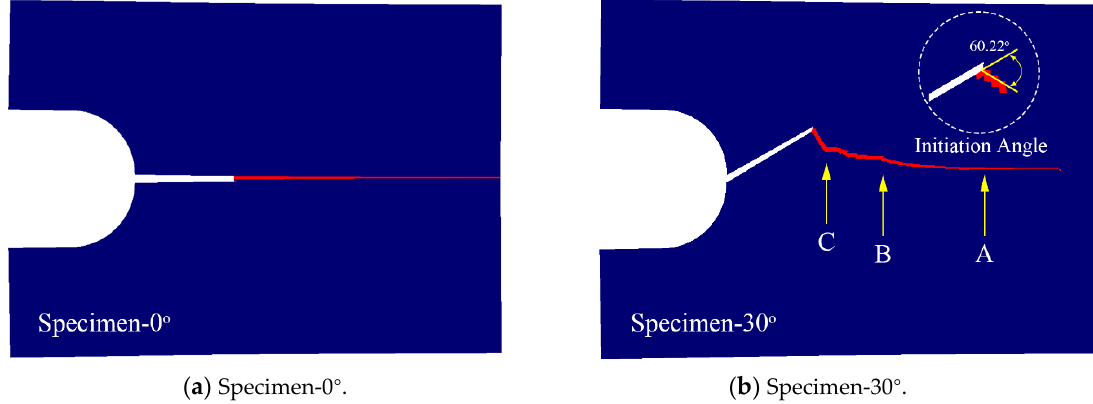
Figure 12. Numerical (AUTODYN) crack propagation paths. ( a ) Crack path of the specimen-0 ° . ( b ) Crack path of the specimen-30 ° .